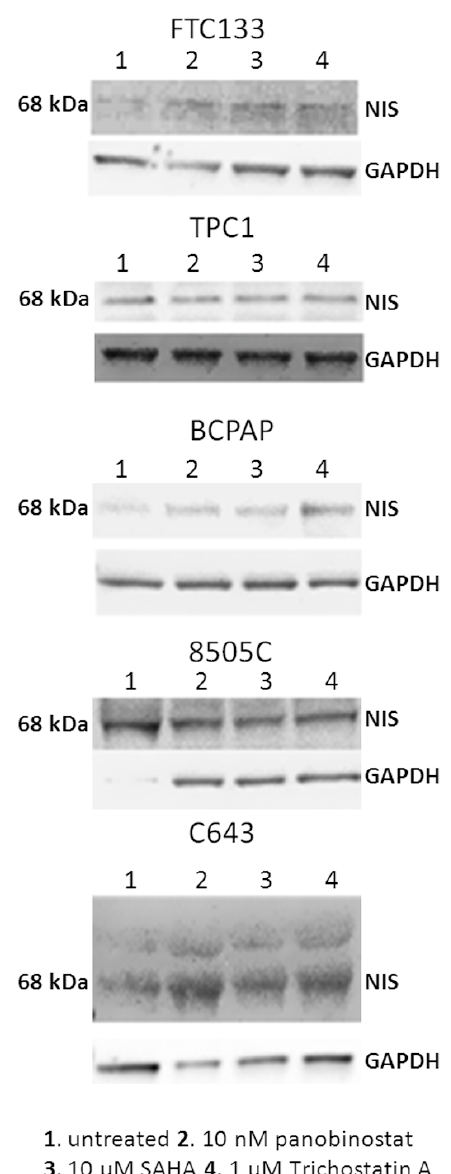
Figure 5. NIS protein level after treatment with deacetylase inhibitors. NIS protein level was detected in FTC133, TPC1, BCPAP, 8505C, and C643 cells after 48 h of treatment with 10 nM panobinostat, 10 µM SAHA, and 1 µM Trichostatin A. The band detected a protein of 68 kDa corresponding to NIS. GAPDH was detected as loading control.